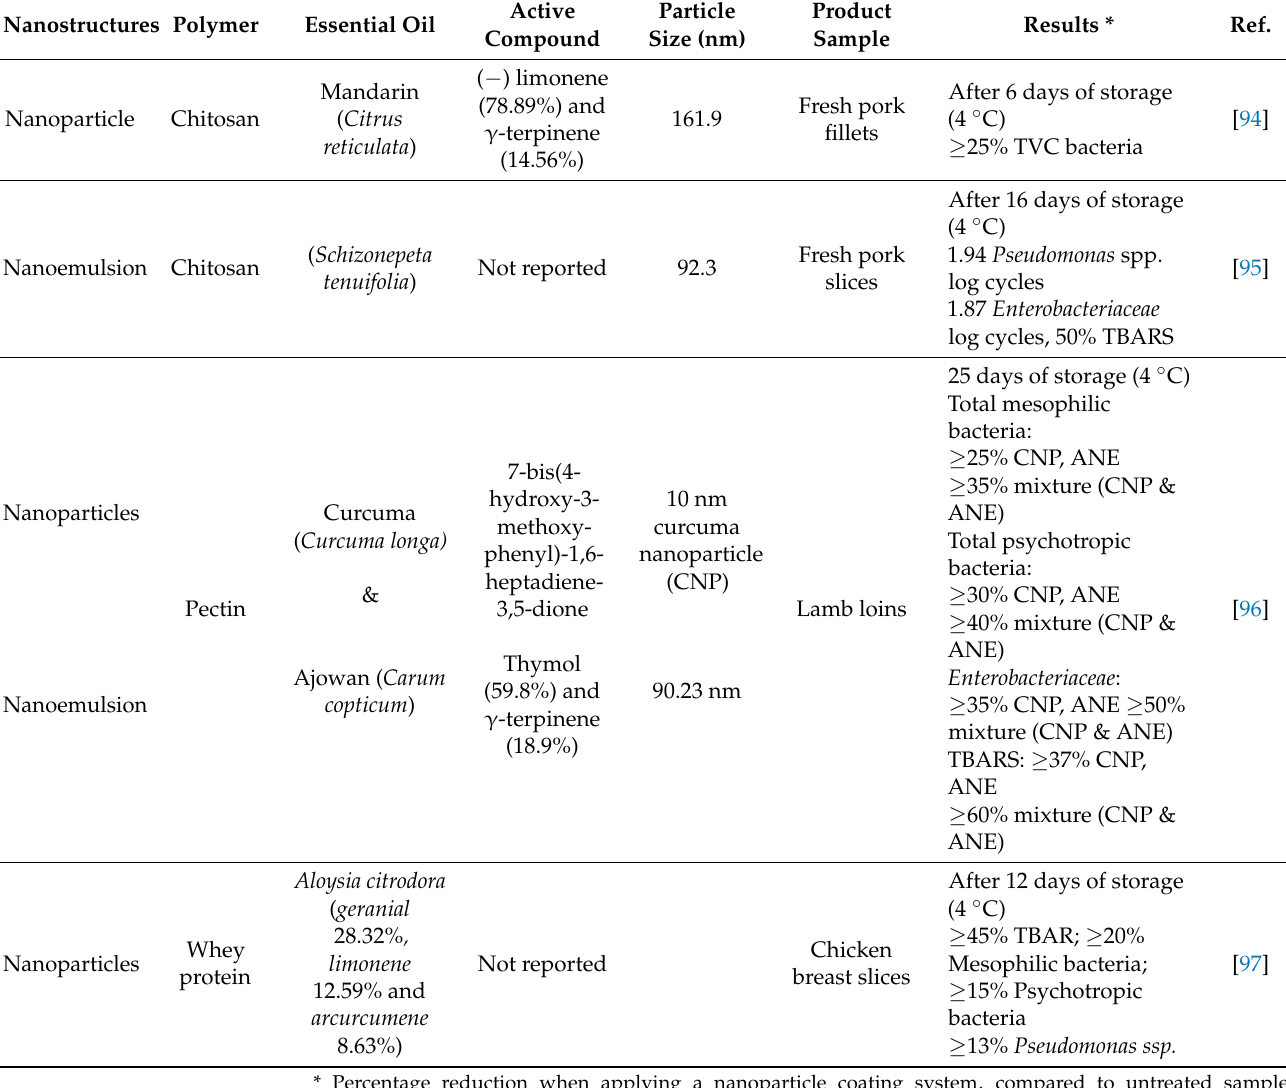
Table 3. Essential oil applications in meat